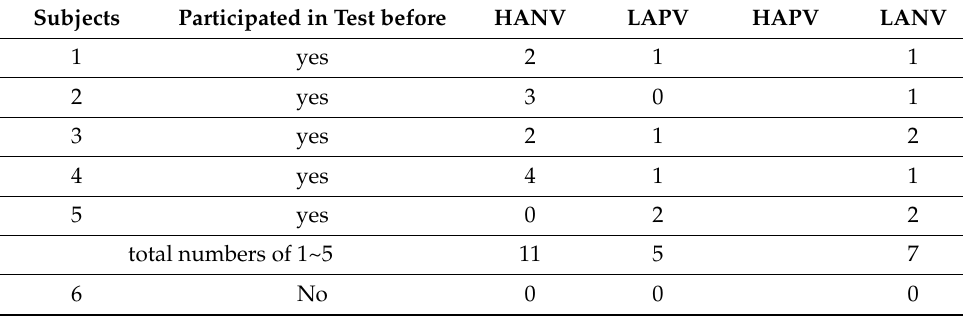
Figure 6. Records of the subjects’ emotions activated by special events. Table 1. The number of the subject’s activated emotions with Approach